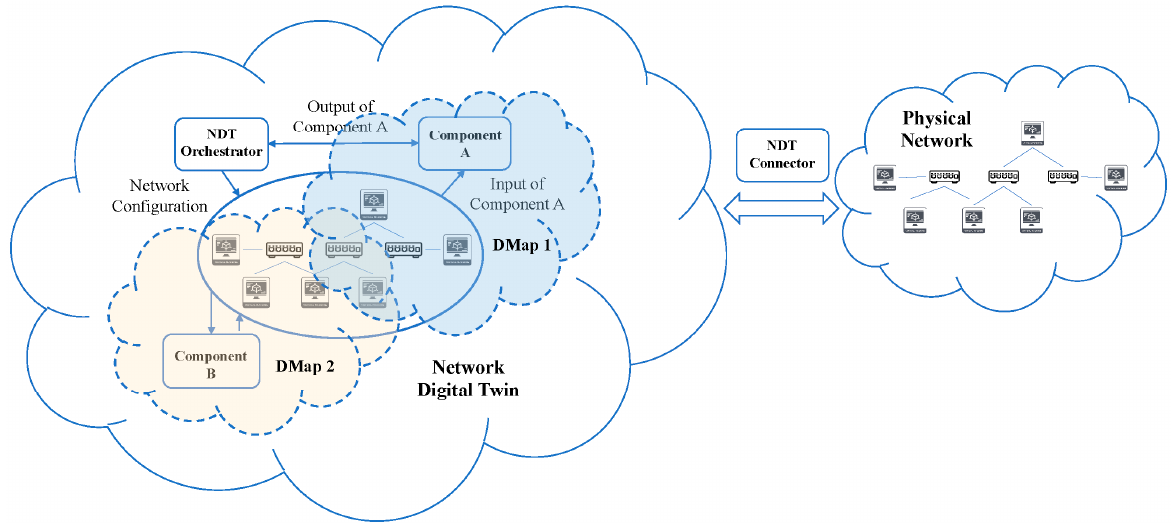
Figure 6. Diagram architecture of the DMap ‐ based NDT.